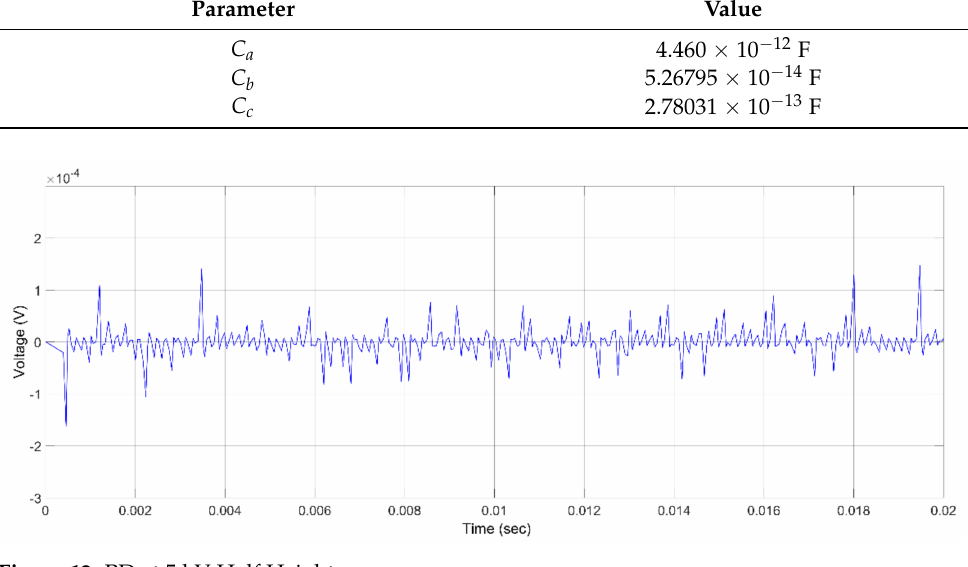
Figure 12. PD at 5 kV-Half Height.